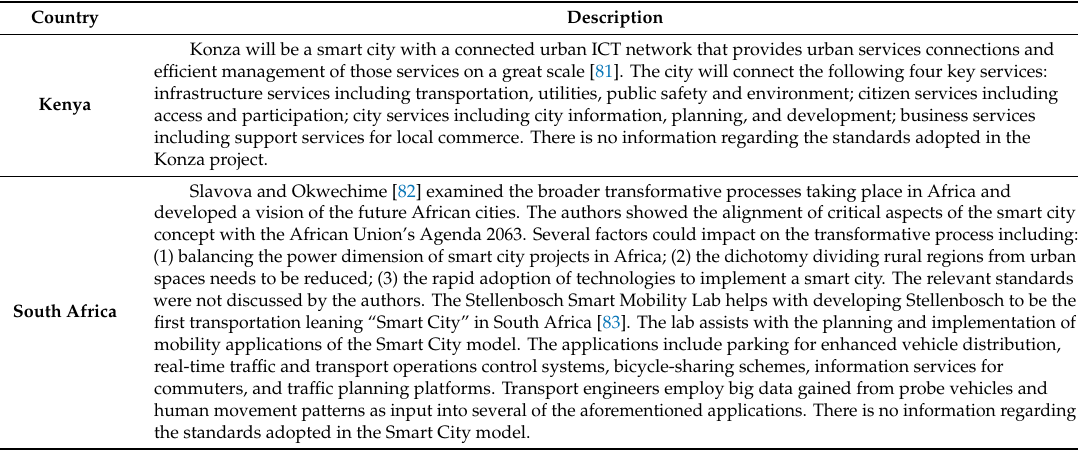
Table 6. Smart cities pilot projects in Africa.